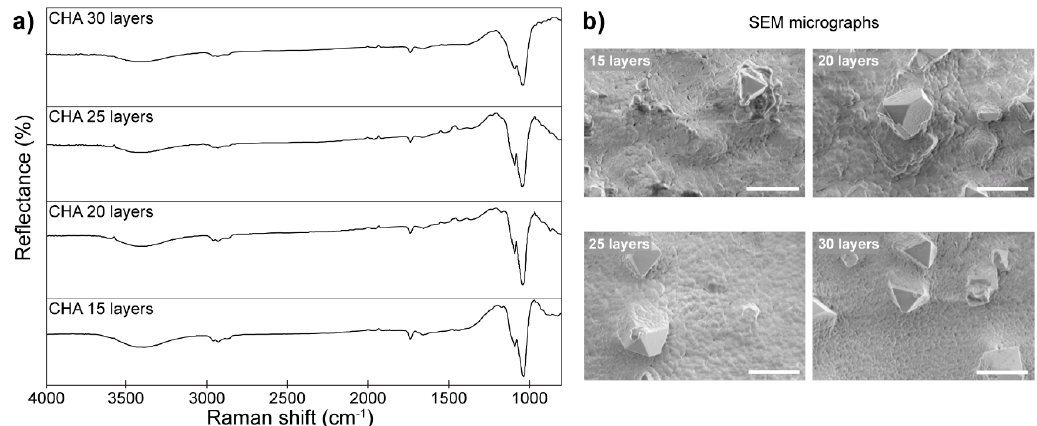
Figure 16. Sol ‐ gel method derived calcium hydroxyapatite (CHA). ( a ) Diffuse reflectance infrared Fourier transform spectroscopy (DRIFTS) spectra of respective CHA layers accompanied by ( b ) SEM micrographs taken at magnification of 15,000×. Scale bars correspond to 3 μ m. Figure adapted with permission from [102].